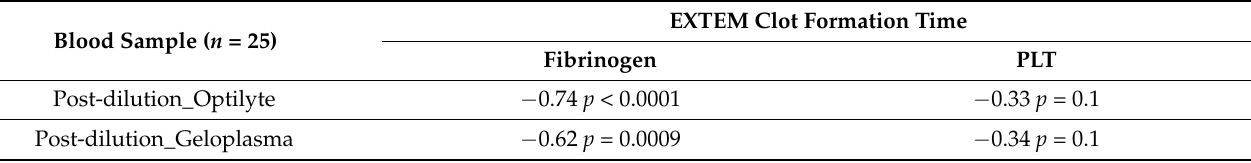
Table 3. Correlations between EXTEM and INTEM clot formation times and standard laboratory tests 1